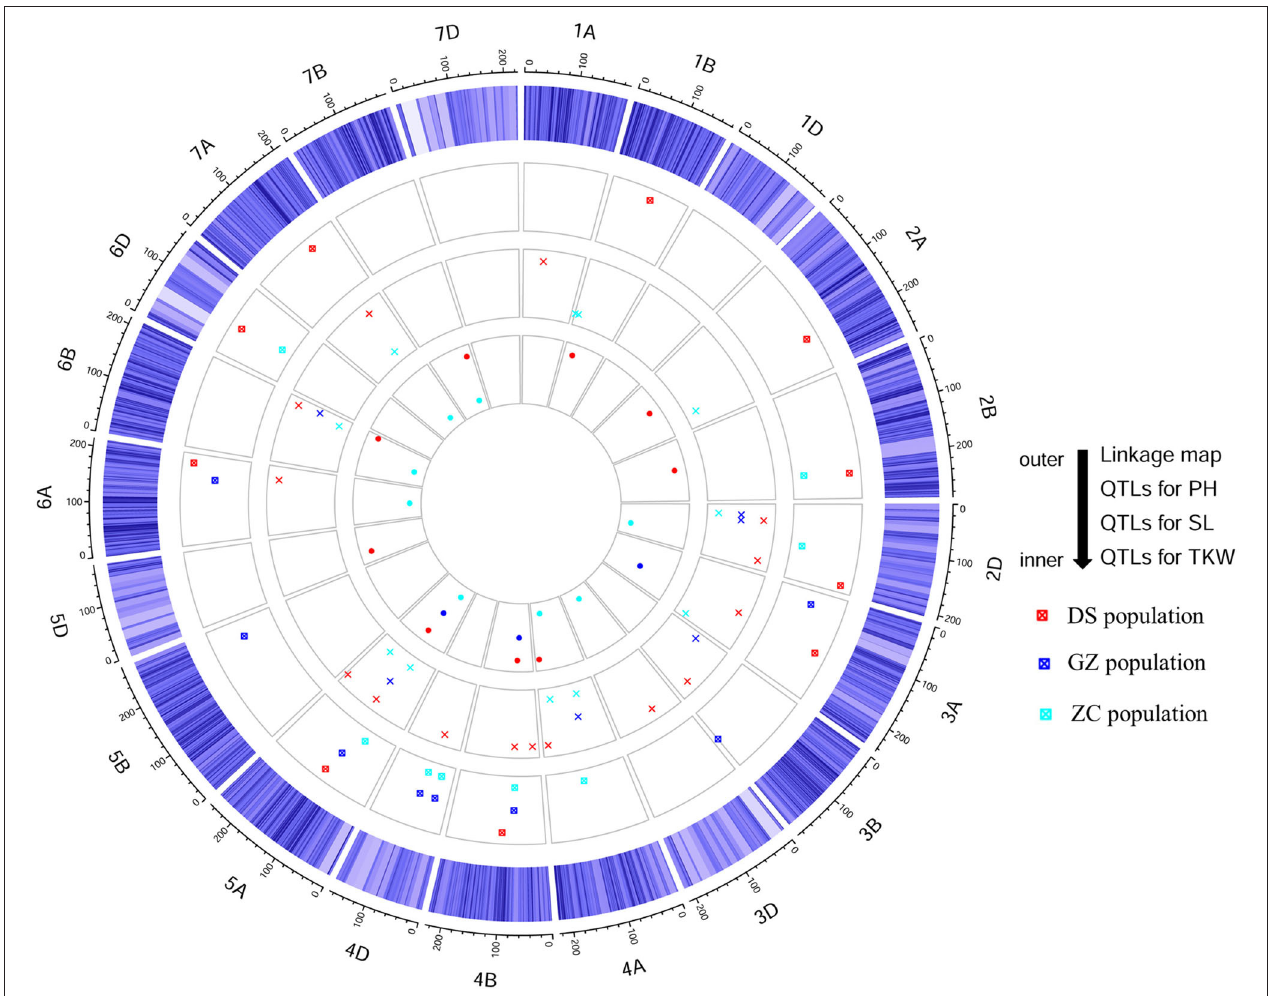
FIGURE 3 | Schematic representation of stable quantitative trait loci (QTLs) for plant height (PH), spike length (SL), and thousand-kernel weight (TKW) detected in three RIL populations, DS, GZ, and ZC from the consensus map.